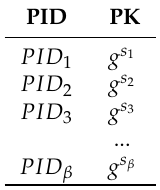
Table 1. Public key list.